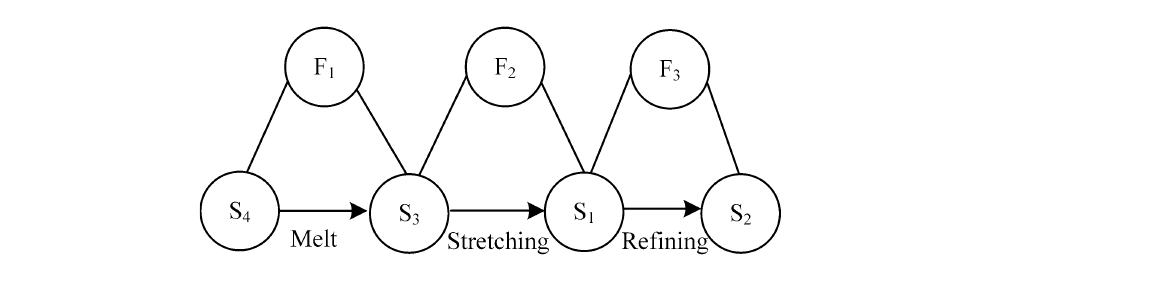
Figure 6. Material-field model of three-dimensional moving